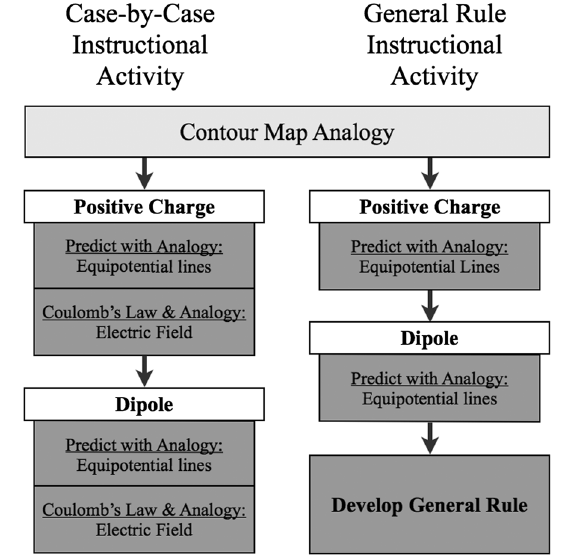
FIG. 3. The sequence of activities for the case-by-case and general rule